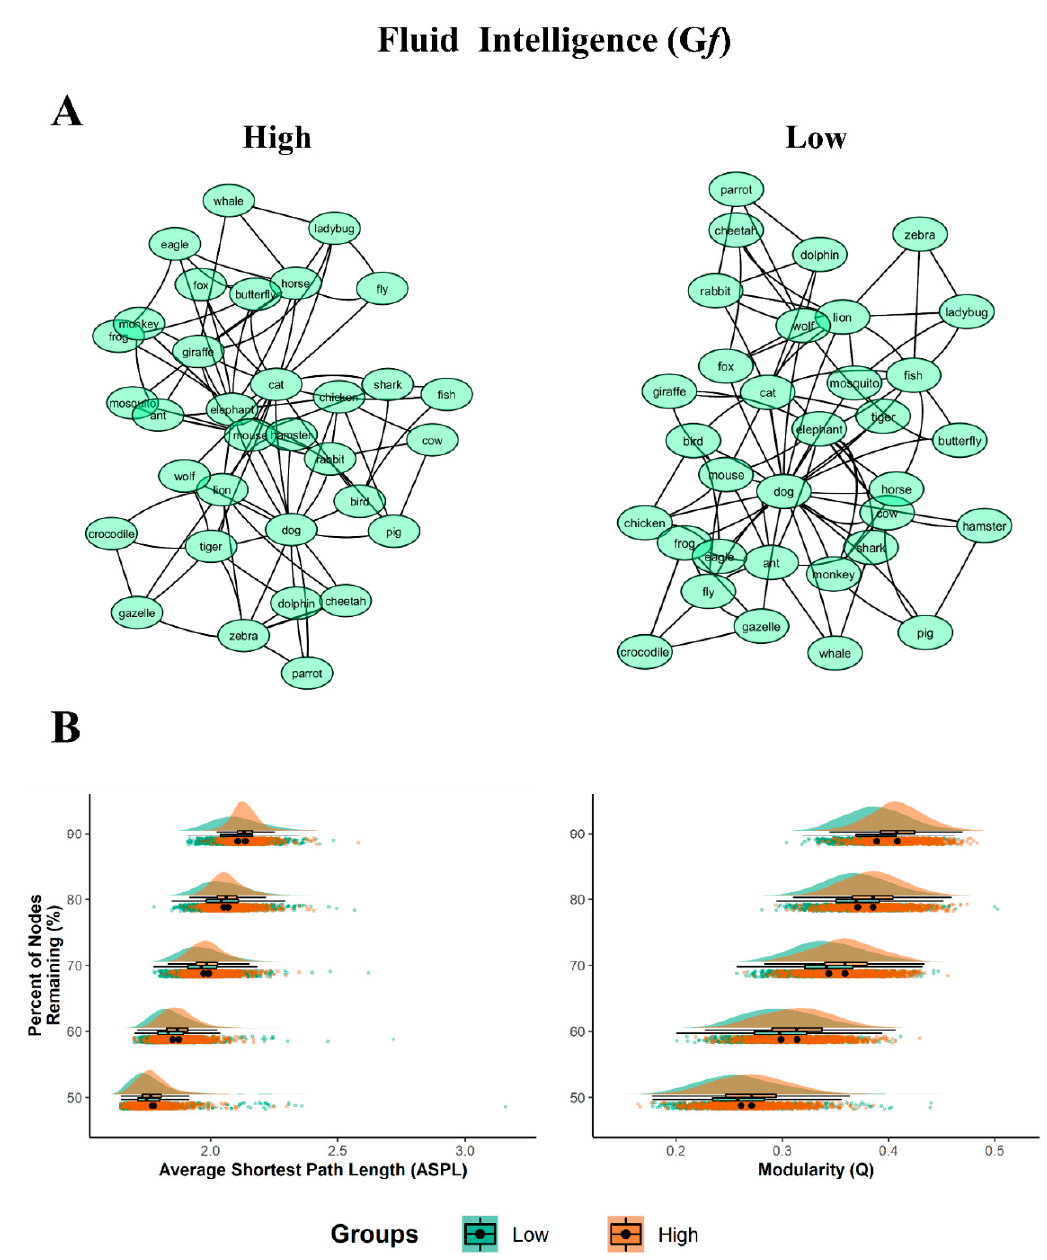
Figure 2. Semantic networks and bootstrapped results for Gf. ( A ) 2D graph visualizations of the Gf groups (high and low). The graphs are unweighted and undirected, with nodes (word responses) represented as circles, and the links between them (edges) represented as symmetrical similarities between two nodes. ( B ) Plots of the bootstrapped partial network measures (1000 samples per nodes remaining percentage). The density plots are above the scatterplots (individual dots depict a single sample), with a black dot representing the mean. The y-axis denotes the percentage of nodes remaining, with the legend of the Gf’ groups (low and high) below the plots. All p < 0.001, with the exception of ASPL at 50% which were not significant.